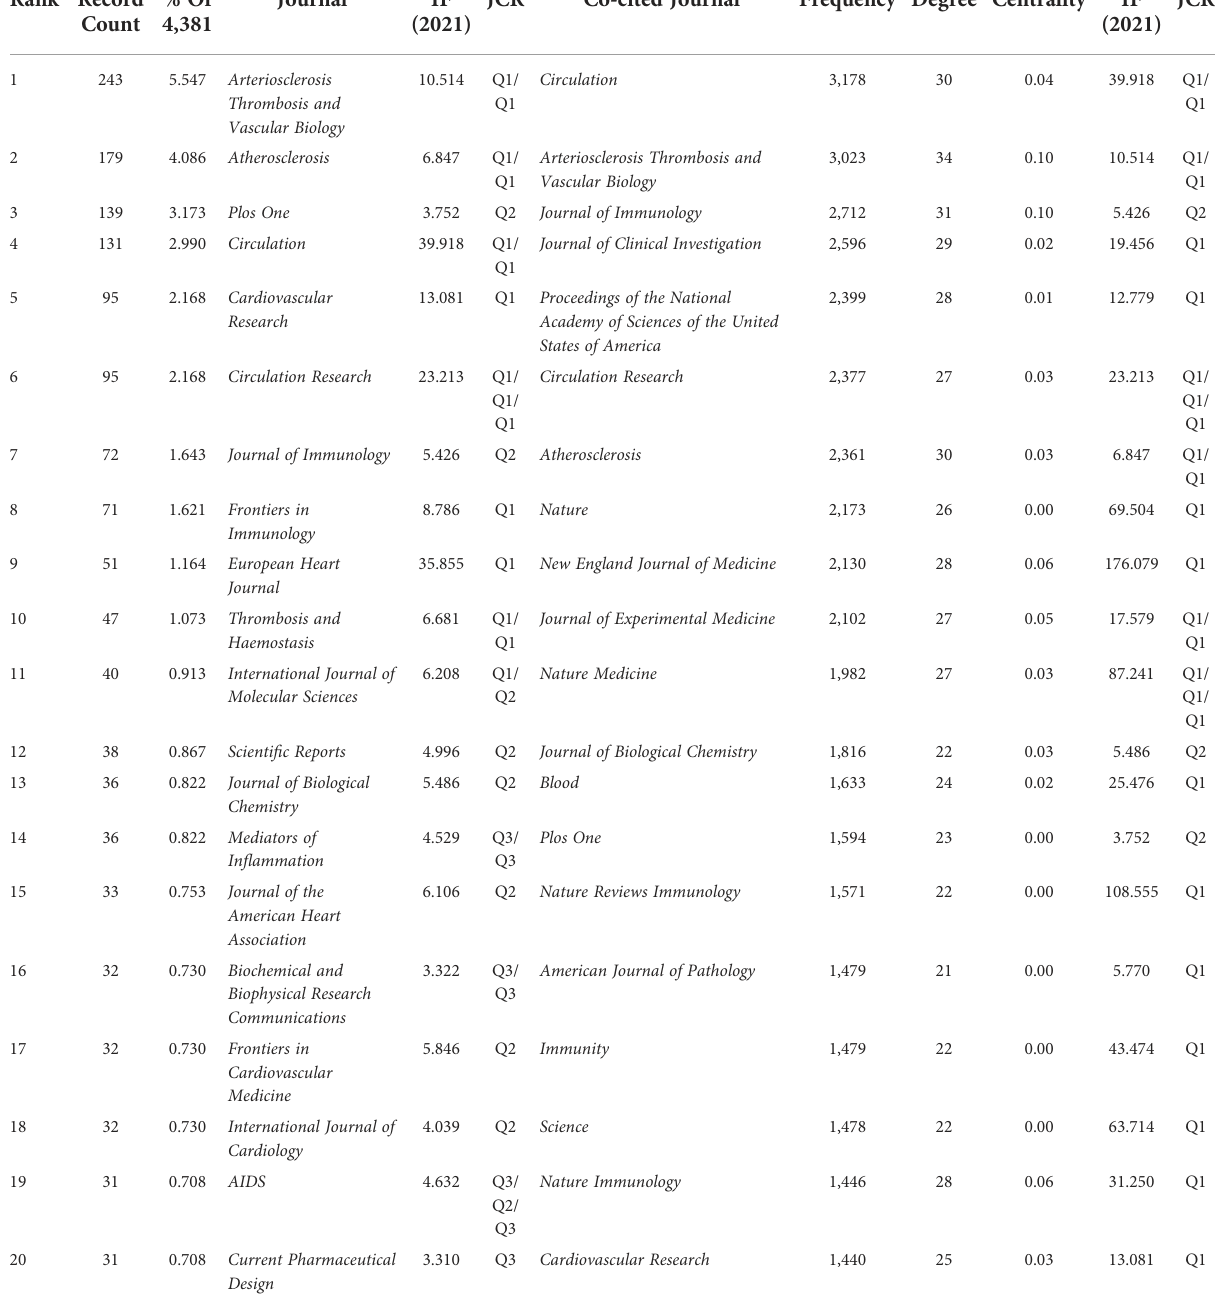
TABLE 6 Top 20 journals and co-cited journals in T cell and AS. Rank Record % Of Count